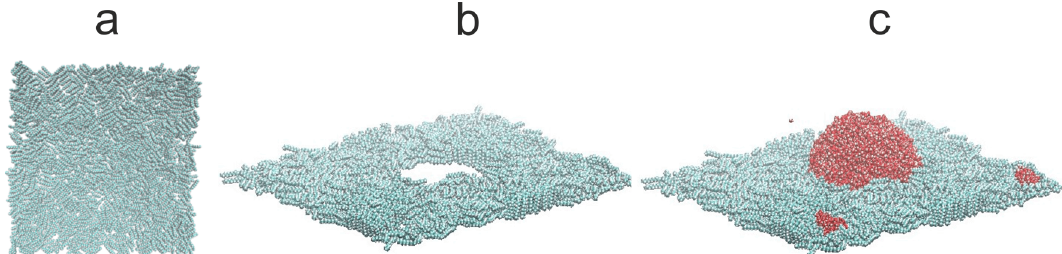
Figure 8. Simulation snapshots (side view) of water droplet on n-decane-covered silicon at C HYDR = 2.92 molec / nm 2 . The snapshot of the alkane on silicon before the water drop was introduced ( a ), the configurations of alkane molecules after the water drop was introduced (( b ) water molecules are not shown), and the snapshots of water drop with the alkane molecules ( c ). Silicon surface is not shown for better clarity.